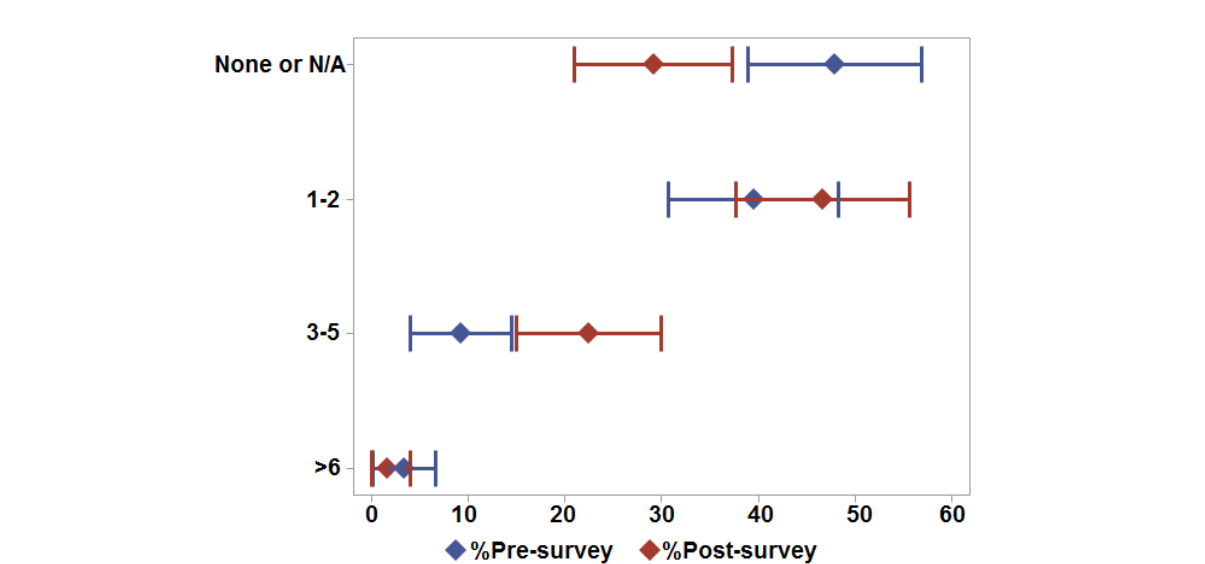
Figure 1. Medical apps owned per student. Proportions (diamonds) and 95% confidence intervals (horizontal lines) for the surveys conducted before (pre-survey) and after (post-survey) the learning experience. N/A: not applicable.